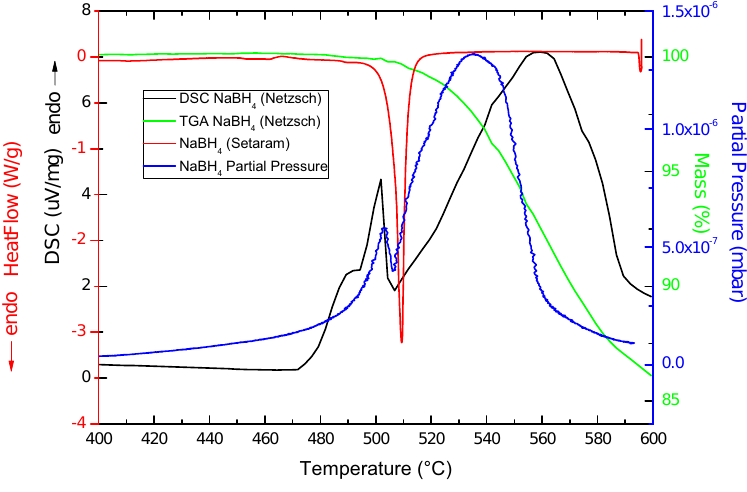
Figure 1. Comparison of the different calorimetry and gravimetric methods used to measure NaBH 4 . Black: DSC-Netzsch in µ V/mg; red: DSC-Setaram in W/g; blue: TPD in mbar of H 2 ; green: TGA in mass % of H 2